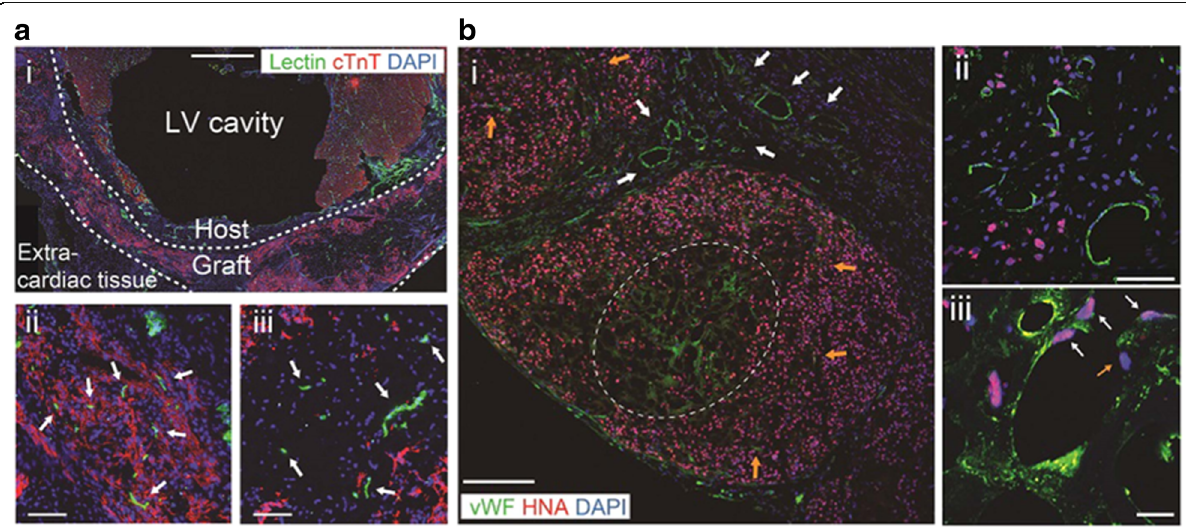
Fig. 2 Vascular network formation after human iPS cell-derived engineered cardiac tissues (hiPSC-ECTs) transplantation onto a rat myocardial infarction model. a cTnT immunostaining for lectin (represents perfused vasculature)-perfused rat heart 4 weeks after implantation of hiPSC-ECTs. (i) Lower magnification image. (ii) and (iii) Higher magnification images. Perfused vasculature among (ii) and at central area (iii) of regenerated myocardium (arrows). b vWF (endothelial cell marker) and HNA double immunostaining. (i) Lower magnification image. White arrows indicate promoted capillary formation around grafted tissue. Orange arrows indicate penetrating vasculature. White dotted line indicates vasculature in the center of grafted tissue. (ii) and (iii) Higher magnification images. (ii) Prominent host-derived (HNA − ) vascular formation around regenerated myocardium. (iii) chimeric vasculature composed of both host (HNA − ; orange arrow) and graft (HNA + ; white arrows) vascular cells. cTnT, cardiac troponin-T; DAPI, 4, 6 diamidino-2-phenylindole; LV, left ventricle; vWF, von Willebrand factor; HNA, human nucleic antigen. Scale bars 1 mm in ( a ) (i), 200 μ m in ( b ) (i), 100 μ m in ( a ) (ii, iii), 50 μ m in ( b ) (ii), 20 μ m in ( b ) (iii). Referred from reference no. 5 with